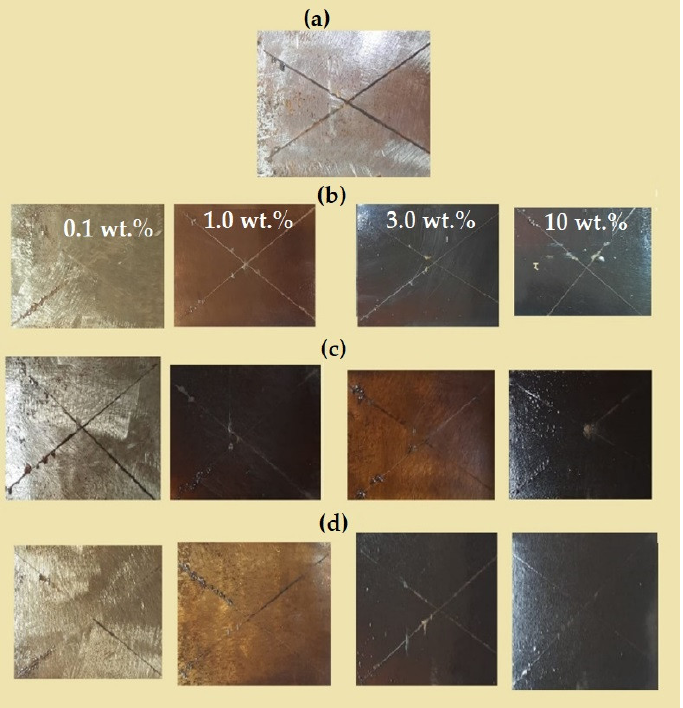
Figure 16. Salt spray resistance of the cured DGEB/ PA in the presence of different weight % of ( a ) blank, ( b ) EOA-Fe 3 O 4 , ( c ) ELOA-Fe 3 O 4 and ( d ) ELNA-Fe 3 O 4 NPs.